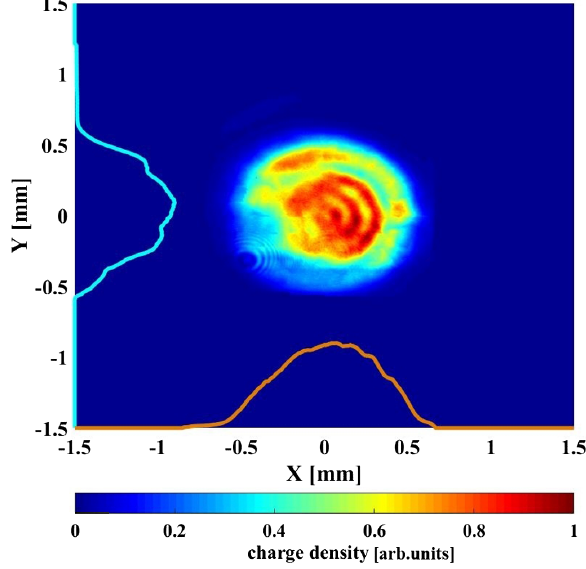
FIG. 11. Transverse distribution of the produced photoelecton bunch via photoemission. Note that the transverse bunch dis- tribution on the cathode, produced by the simulation, is on the basis of the measured laser transverse distribution and the measured cathode QE map as shown in Figs. 2 and